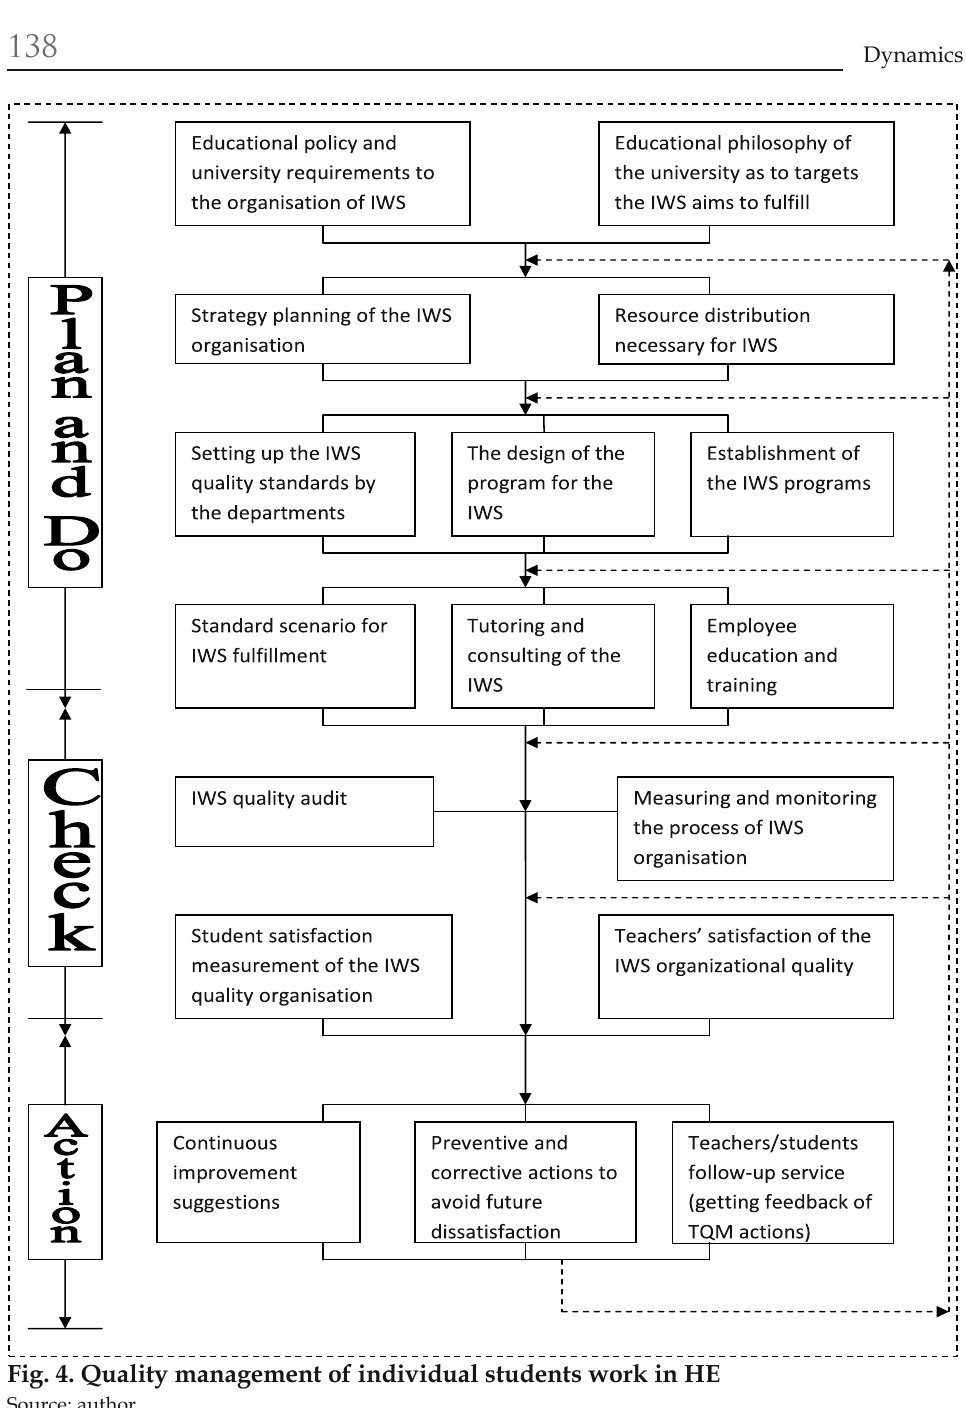
(cid:41)(cid:76)(cid:74)(cid:17)(cid:3)(cid:23)(cid:17)(cid:3)(cid:52)(cid:88)(cid:68)(cid:79)(cid:76)(cid:87)(cid:92)(cid:3)(cid:80)(cid:68)(cid:81)(cid:68)(cid:74)(cid:72)(cid:80)(cid:72)(cid:81)(cid:87)(cid:3)(cid:82)(cid:73)(cid:3)(cid:76)(cid:81)(cid:71)(cid:76)(cid:89)(cid:76)(cid:71)(cid:88)(cid:68)(cid:79)(cid:3)(cid:86)(cid:87)(cid:88)(cid:71)(cid:72)(cid:81)(cid:87)(cid:86)(cid:3)(cid:90)(cid:82)(cid:85)(cid:78)(cid:3)(cid:76)(cid:81)(cid:3)(cid:43)(cid:40)